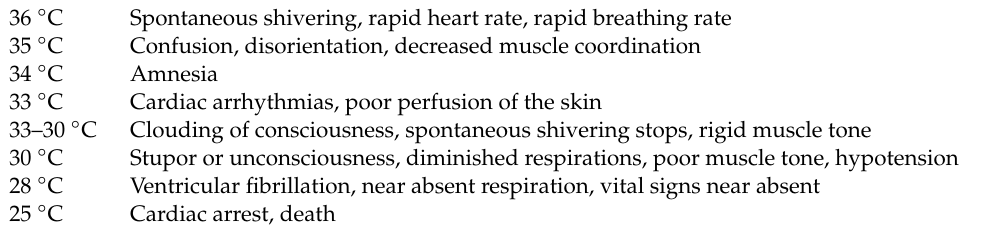
Table 3. Symptoms of cold-water immersion according to core body temperature